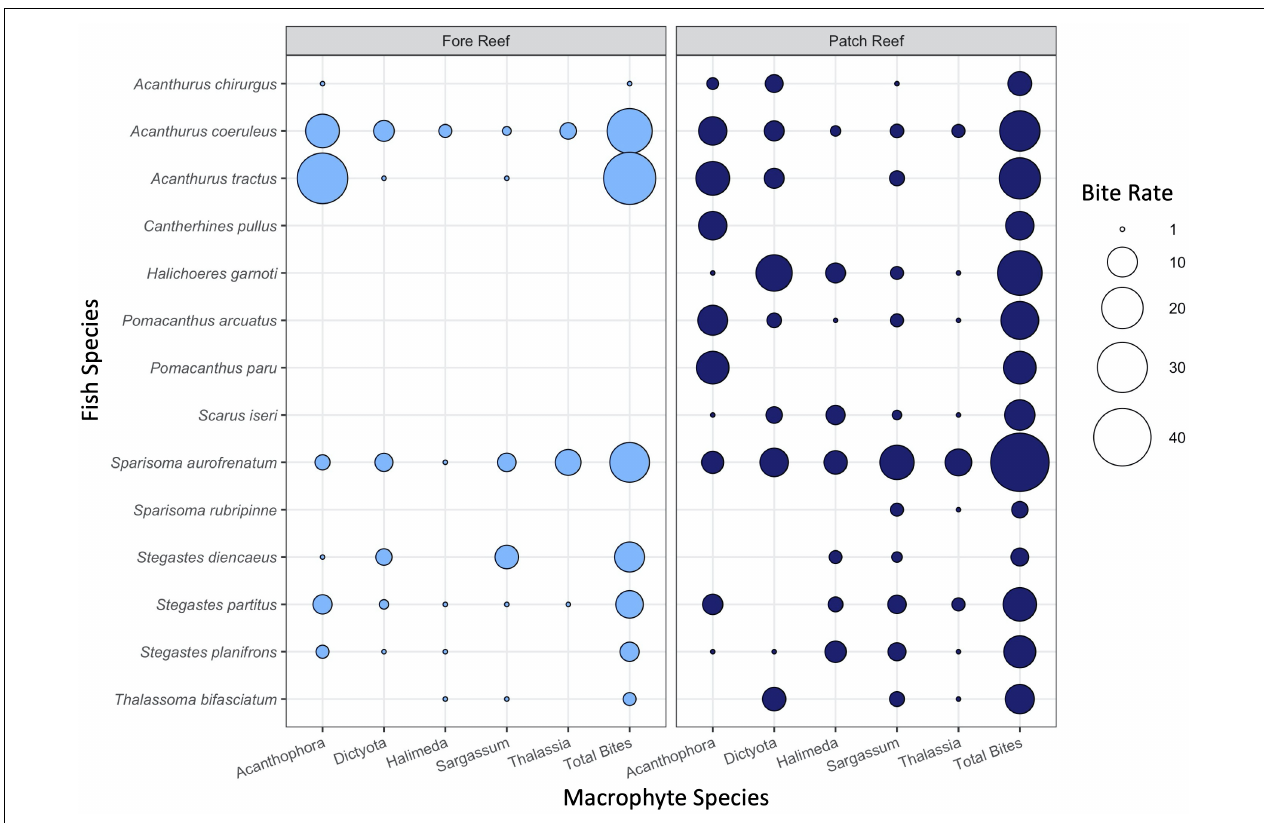
FIGURE 6 | Mean bite rate for each fish herbivore per 1 h on each macrophyte observed in 2017 patch and fore reef. The size of the point is scaled by the total number of bites across all species and colored by